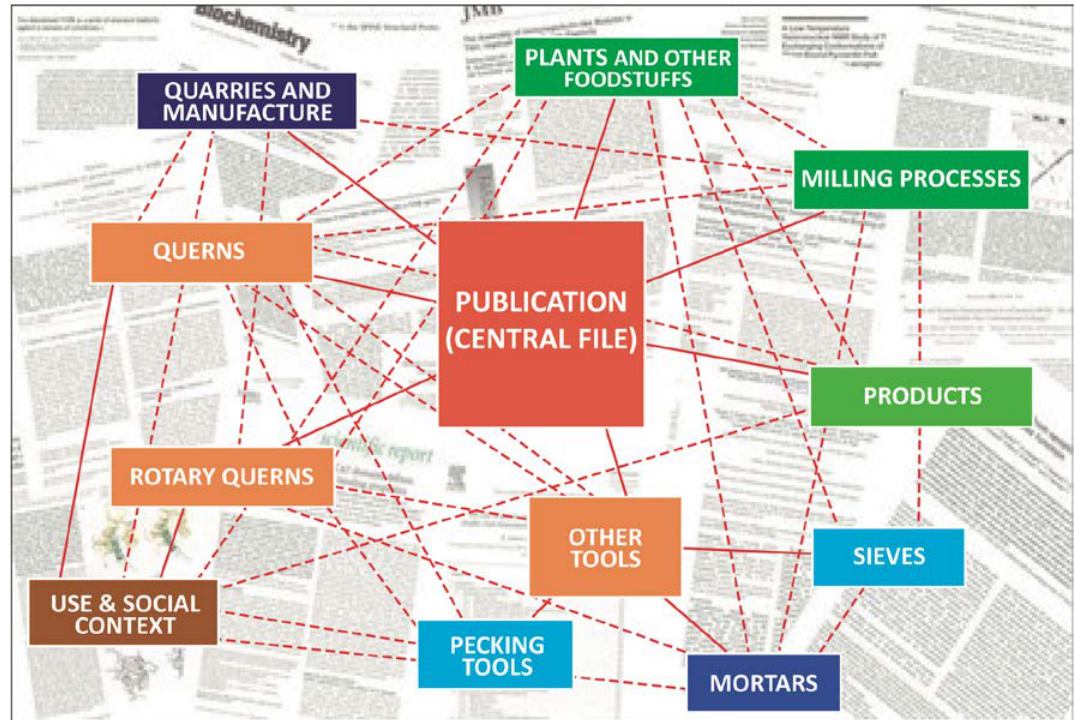
Figure 1. Aspects on grinding systems gleaned from specialised publications that serve as the basis for data